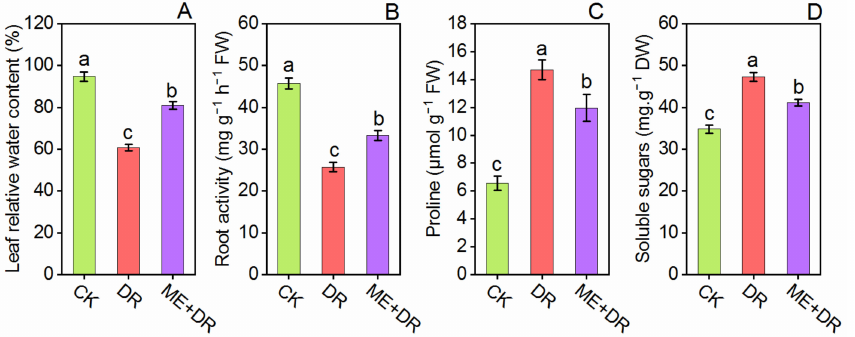
Figure 5. Exogenous supplementation of melatonin promoted level of relative water content ( A ), and root activity ( B ); reduced level of proline ( C ) and soluble sugar ( D ) content of tomato seedling under drought stress conditions. Means ± standard error, n = 3, significant difference are exhibited by lowercase letters ( p ≤ 0.05), according to LSD test.